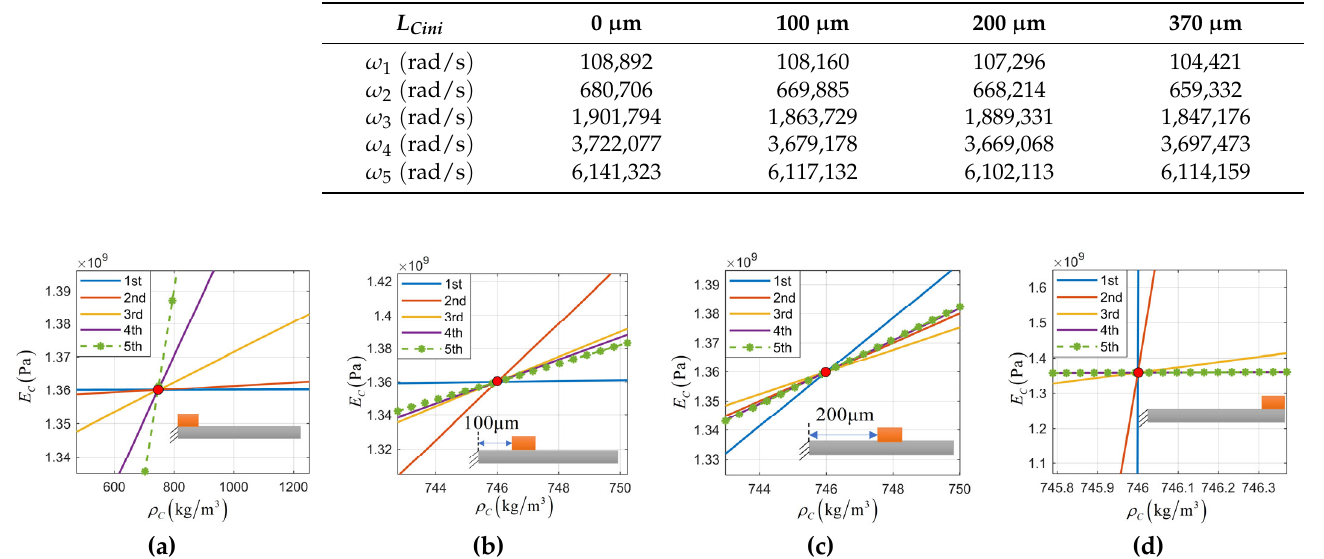
E ‐  curves. The red points denote the ideal C C L on the Cini